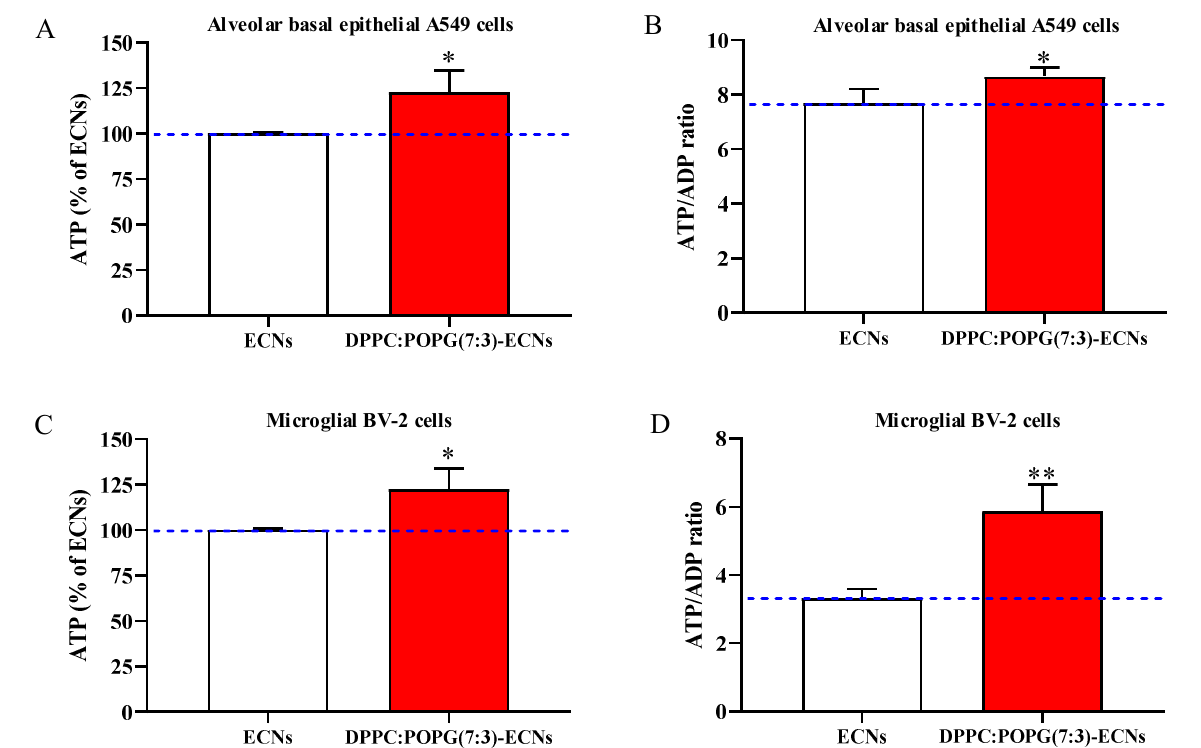
Figure 3. Values of adenosine triphosphate (ATP) and mitochondrial phosphorylating capacity (ATP/adenosine diphos- phate (ADP) ratio) of A549 ( A , B ) and BV-2 ( C , D ) cells following 24 h of ECNs (2 µg/mL) challenge without and with the LS DPPC:POPG(7:3) (indicated as DPPC:POPG(7:3)-ECNs). ECNs = engineered carbon nanodiamonds; DPPC = dipal- mitoyl phosphatidylcholine; POPG = 1-palmitoyl-2-oleoyl-sn-glycero-3-phospho-(1′-rac-glycerol). In the case of ( A ) and ( C ), data are the mean of three independent experiments and are expressed as the percent variation, with respect to the quantity of ATP recorded in ECNs-treated cells. Standard deviations are represented by vertical bars. * Significantly dif- ferent from ECNs-treated cells, p < 0.05; ** significantly different from ECNs-treated cells, p < 0.01.